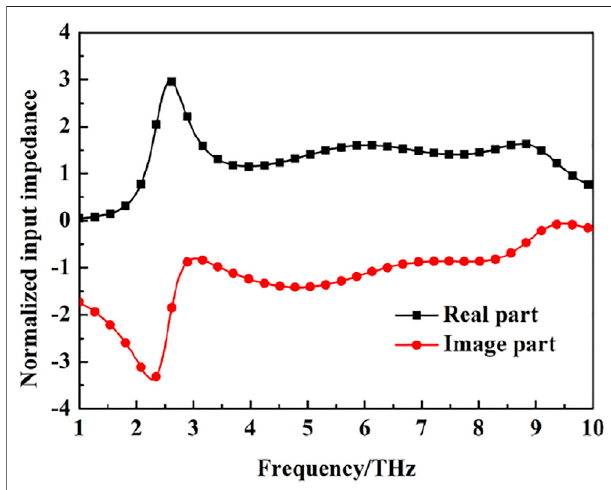
FIGURE 4 | The surface current of the metamaterial absorber at 6 THz ( T (cid:1) 300 K), (A) VO 2 disk; (B) gold ground.